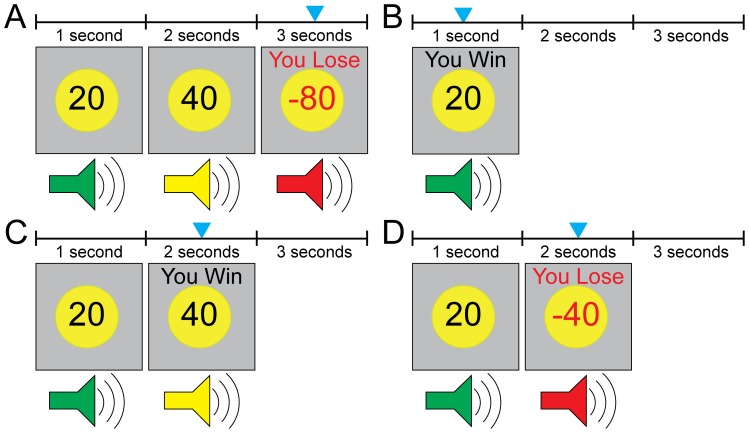
An illustration of four different trial types from the risky gains task: (A) lose 80, (B) win 20, (C) win 40 and (D) lose 40.The blue arrow indicates participant response to select the value on screen.